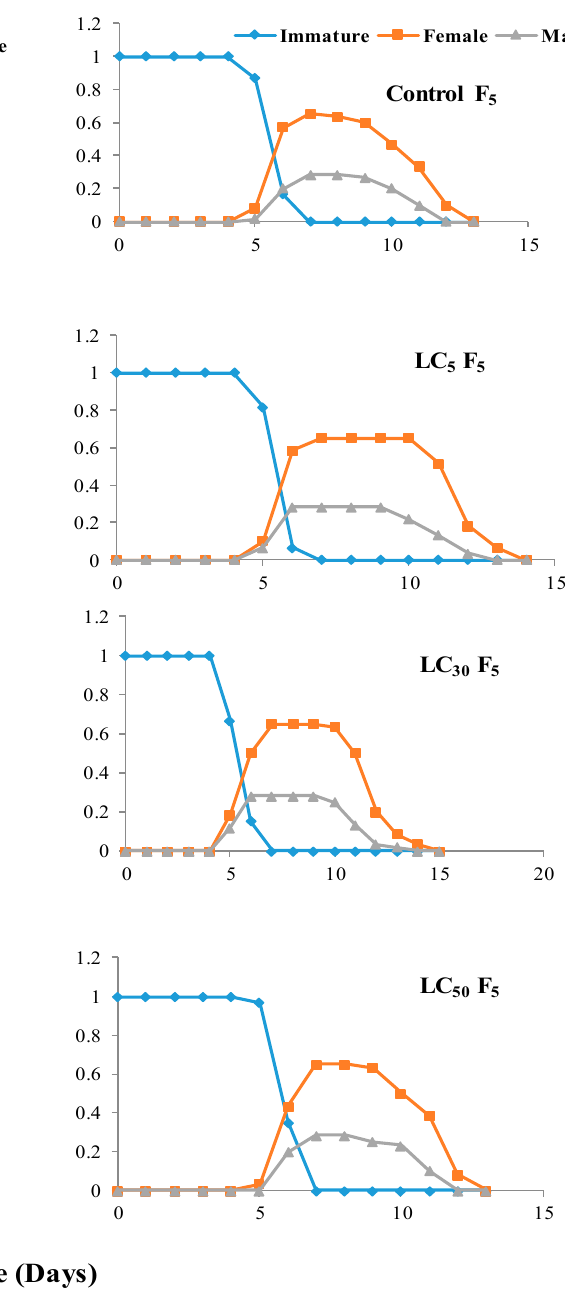
Figure 1. Age–stage–specific survival rates ( S xj ) of T . chilonis adults treated with acetone and LC 5 , LC 30 , and LC 50 concentrations of imidacloprid in F 1 and F 5 generations.